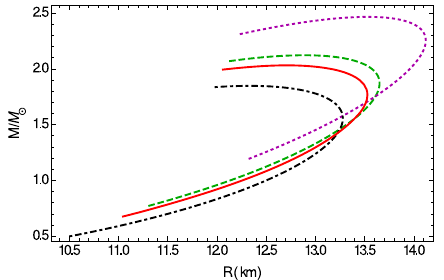
Fig. 10 Variation of the total mass M / M (cid:2) as a function of the radius of the star R for three-form field photon stars, for three different values of the constant ¯ λ : ¯ λ = 0 (dashed curve), ¯ λ = 0 . 02 (dotted curve), and ¯ λ = − 0 . 02 (dot-dashed curve), respectively. The solid curve represents the mass–radius relation for general relativistic photon stars Table 3 The maximum mass and the corresponding radius for three- form field photon stars with constant potential ¯ λ − 0 . 02 0 .